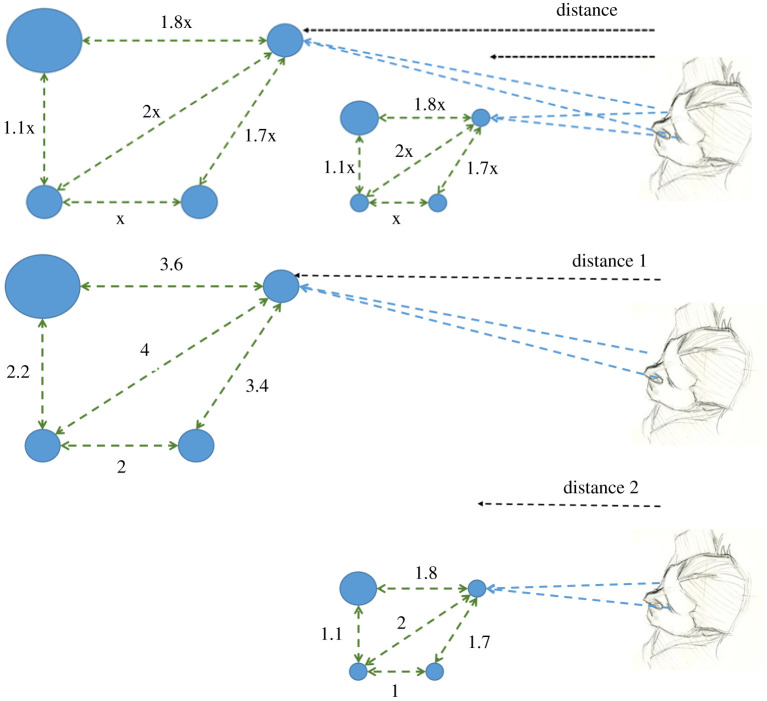
The distinction between the perception of relative and scaled (absolute) depth. In the top panel, the observer has information about the relative ratios of separations between the four objects, but not the actual values of the separations (units of distance). The observer's perception of 3D shape and layout is, therefore, ambiguous up to a uniform scaling factor. In the two lower panels, the observer perceives the actual separations between the objects in some egocentric units (units of distance) relevant for interaction.